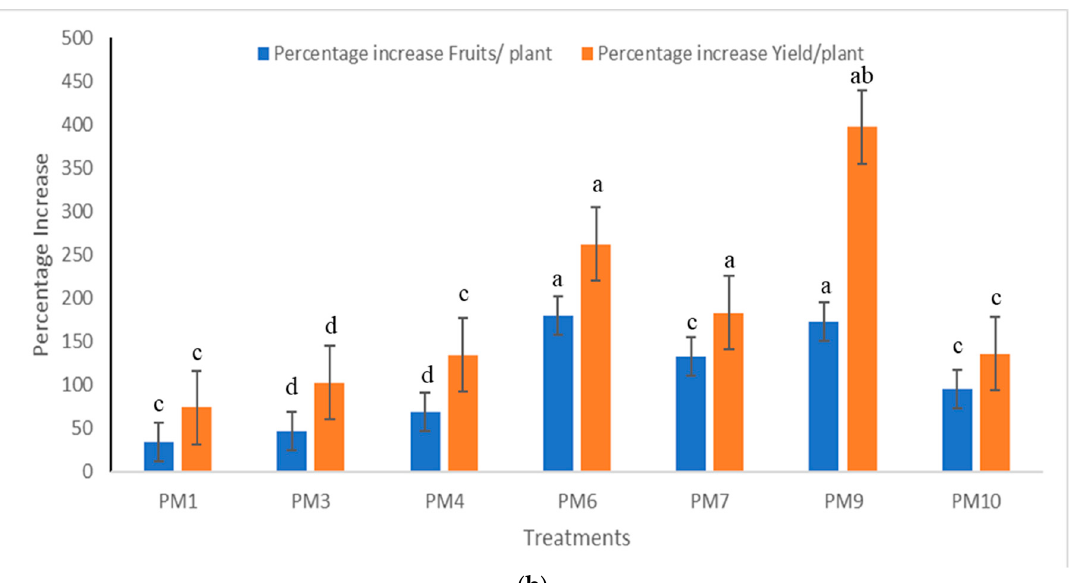
Figure 5. Impact of PGPR’s consortium on ( a ) growth of plants ( b ) growth and yield of capsicum under field conditions. Different letters mean significant differences among categories ( p < 0.05). Error bars indicate ± SD. PM1—Control, PM3—Benomyl, PM4—Captan, PM6—Recommended dose of NPK, PM7—Soil fumigation with MeBr (425 kg/ha broadcast 98:2 MeBr:chloropicrin), PM9—PGPR’s